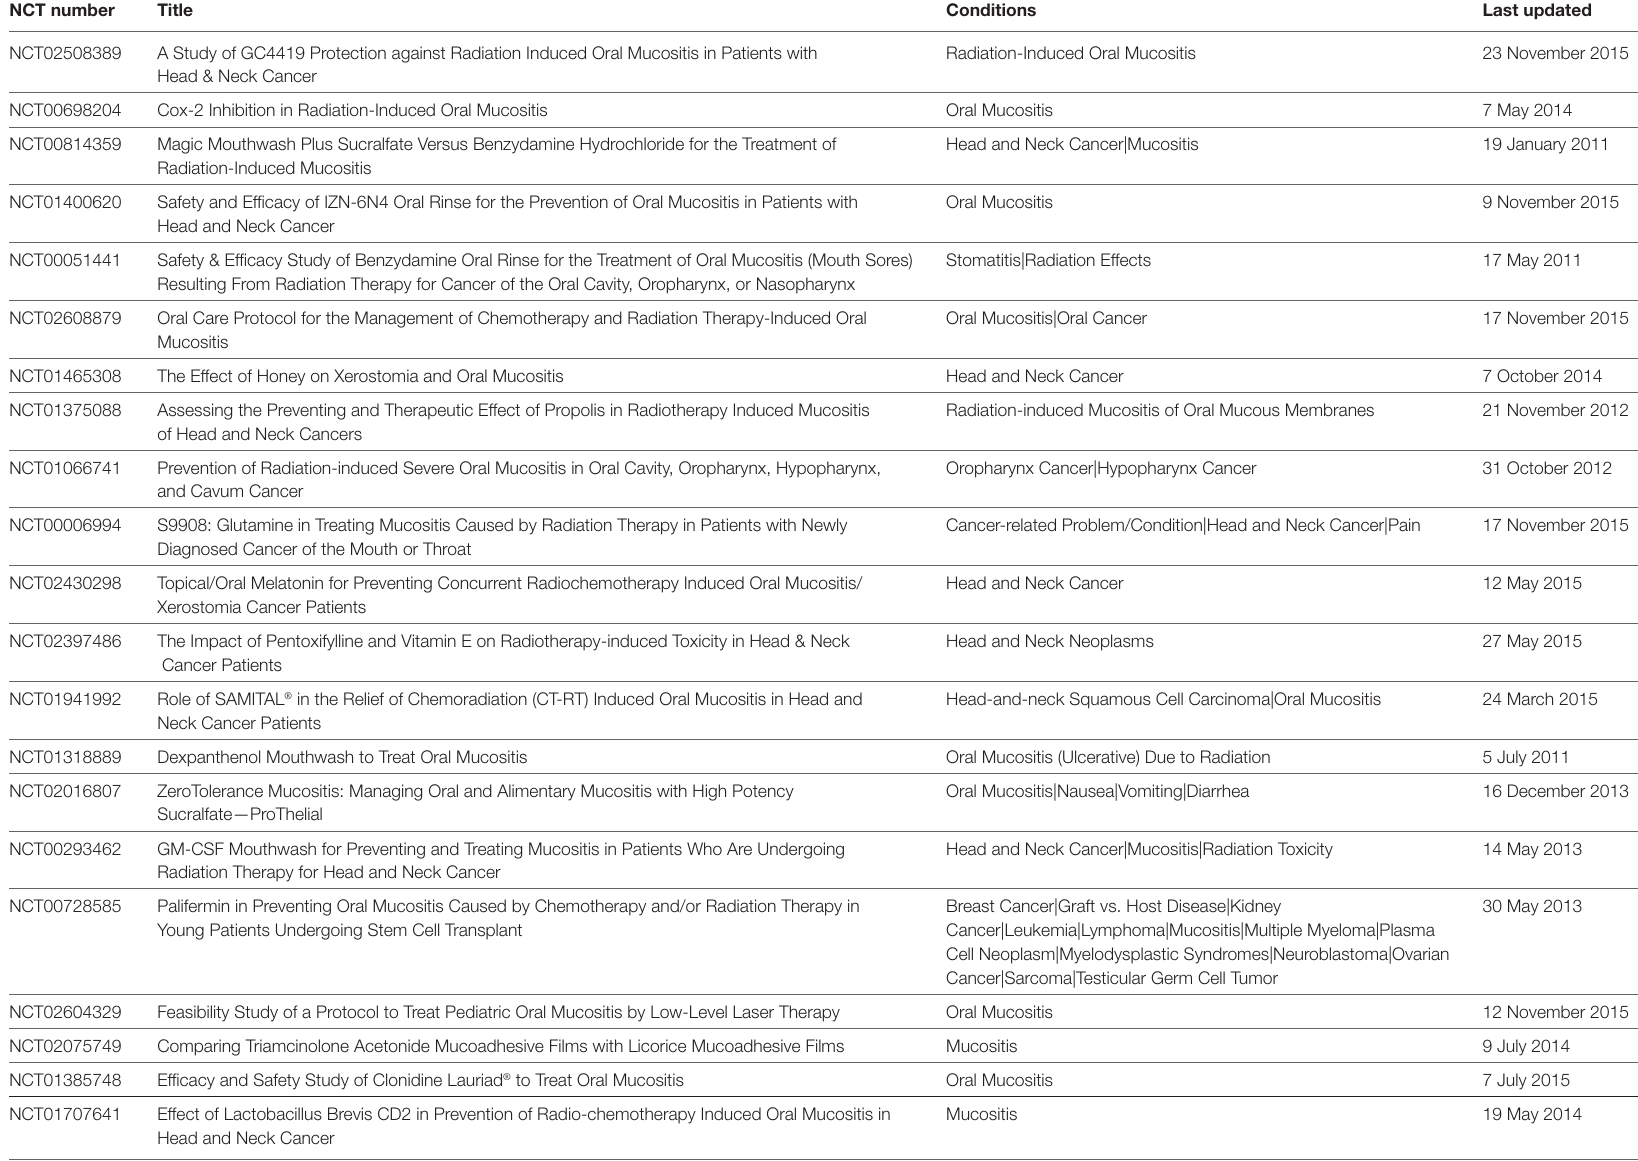
TAbLe 11 | Clinical trials for RiOM as listed on http://www.ClinicalTrials.gov when searched in November 2015. NCT